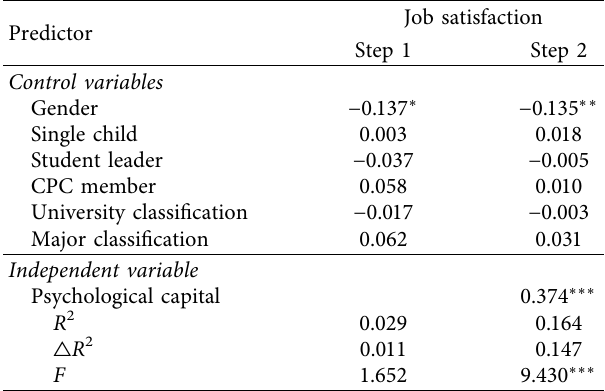
Table 6: Hierarchical regression of the influence of psychological capital on job satisfaction.